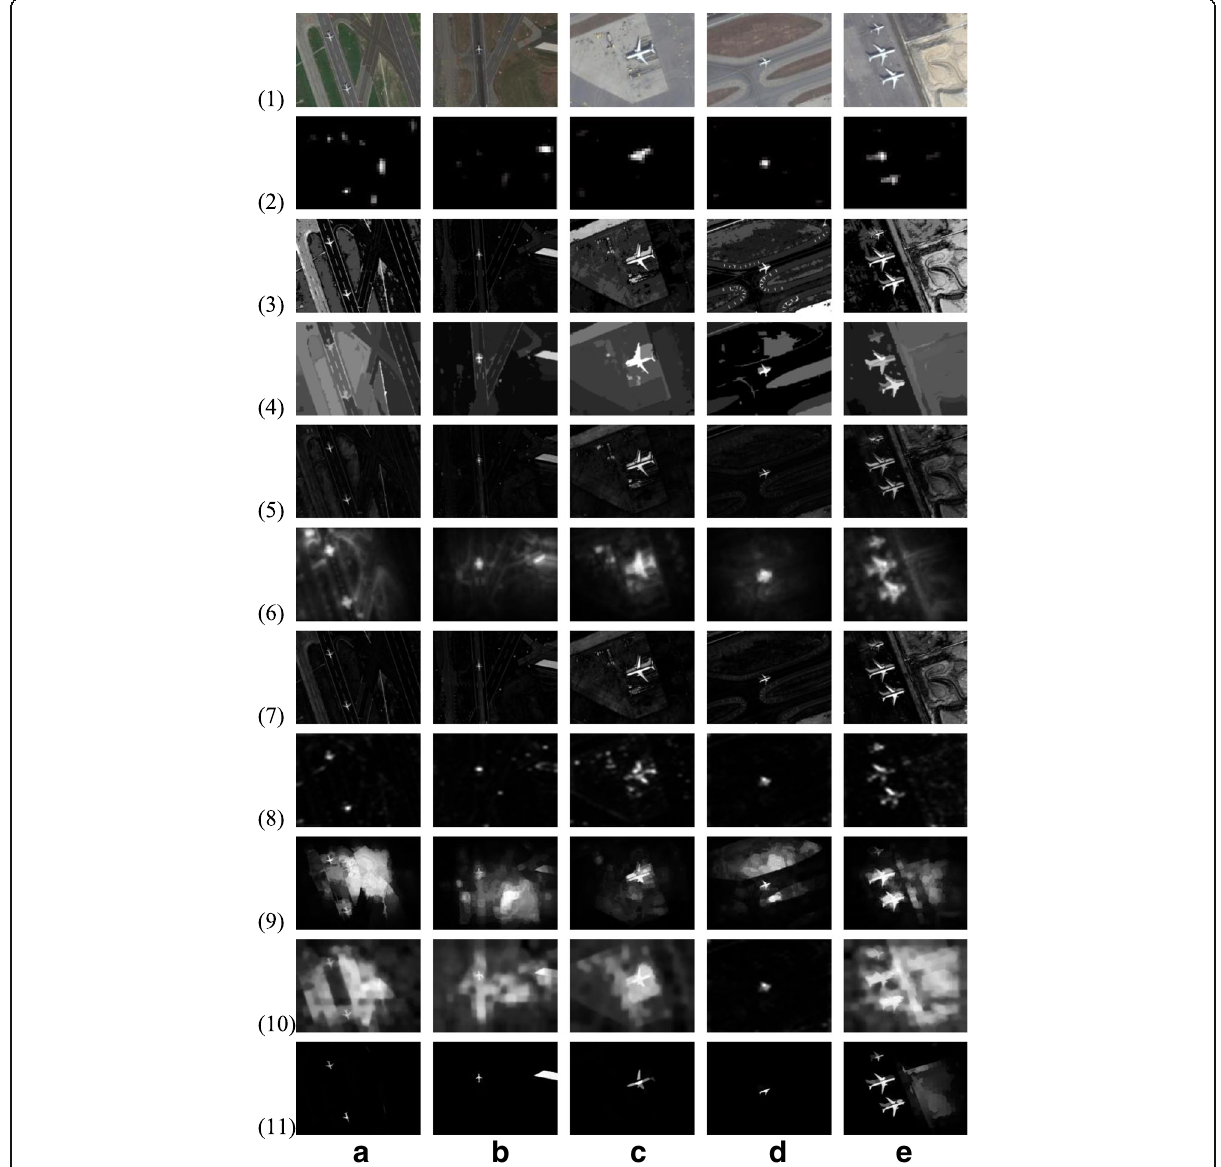
Fig. 5 Comparison of saliency images. (a) Grassland. (b) Land. (c) Cement. (d) Only a single aircraft in each image. (d) Multiple aircrafts in each image. (1) The original remote sensing image. (2) IT [33]. (3) HC [36]. (4) RC [36]. (5) FT [37]. (6) CA [38]. (7) LC [39]. (8) SR [40]. (9) DSR [41]. (10) BL [42]. (11) Our